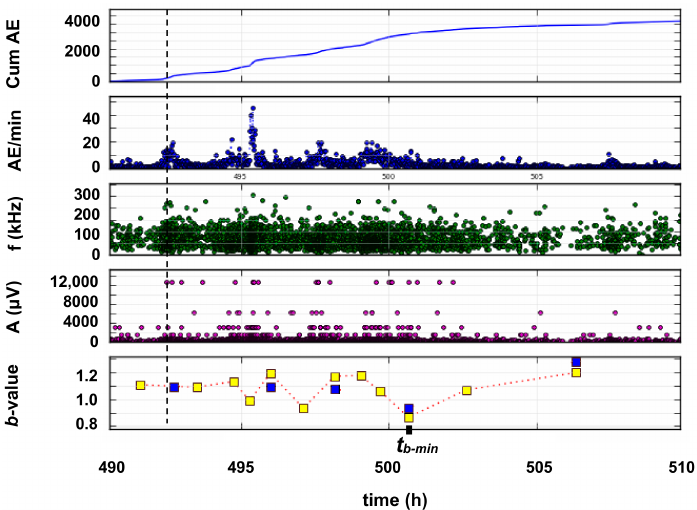
Figure 4. From top to bottom: accumulated number of AE signals; AE signals count rate; time series of AE signals frequencies (derived from signal duration and ring-down count) and amplitudes; b -value over time calculated using groups of, respectively, 300 (yellow squares), and 800 (blue squares) numbers of signals. The dashed line indicates a critical point revealed by the natural time